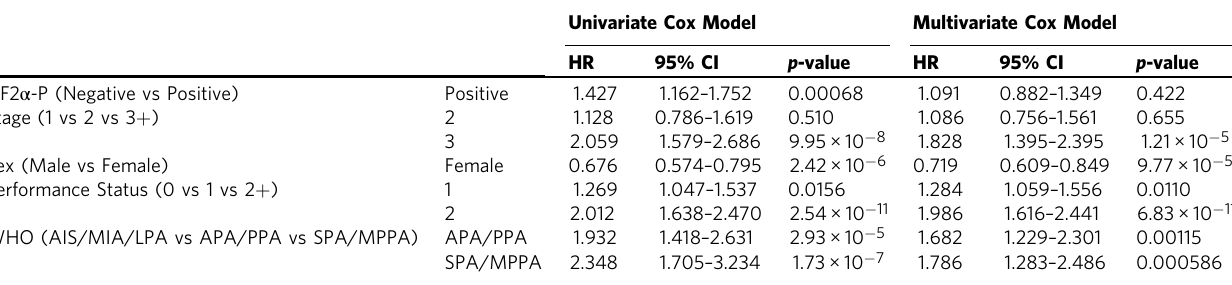
Table 1 Univariate and multivariate overall survival model including phospho-eIF2 α (eIF2 α -P) H-score, stage, sex, performance status, and WHO classi fi cation. Only complete cases included [ n = 842, number of events = 583, number of patient years = 18 (1998 –